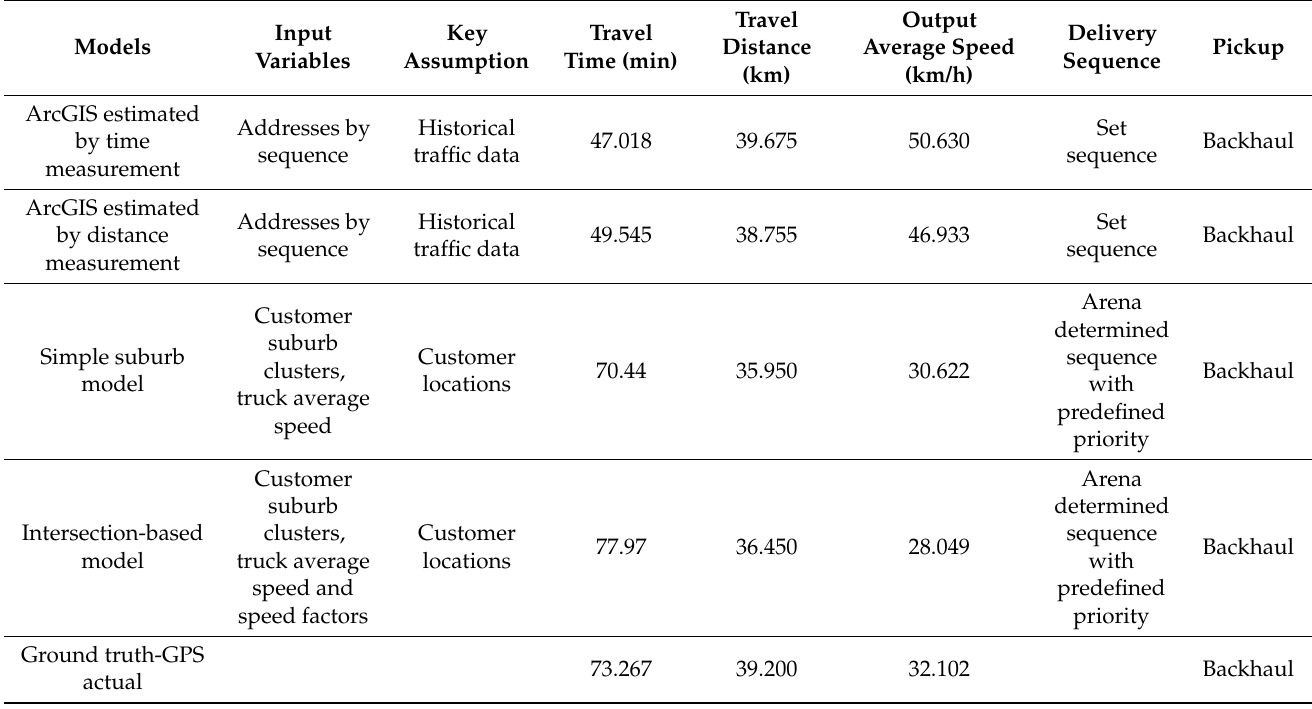
Figure 8. GIS estimated routes against GPS data ( a ) defined sequence by time measurement; ( b ) defined sequence by distance measurement. Table 6. Results comparison.